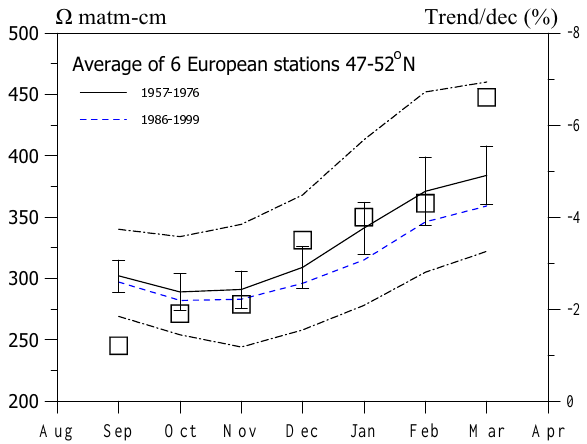
Fig. 1. Monthly long-term average total ozone of 6 European sta- tions in the 47–52 ◦ N belt for the period of 1957–1976 (solid line) and 1986–1999 (dashed line). The dash-dotted lines represent the mean maximum and mean minimum values for each month. The corresponding long-term trend in % per decade for each month is indicated with open